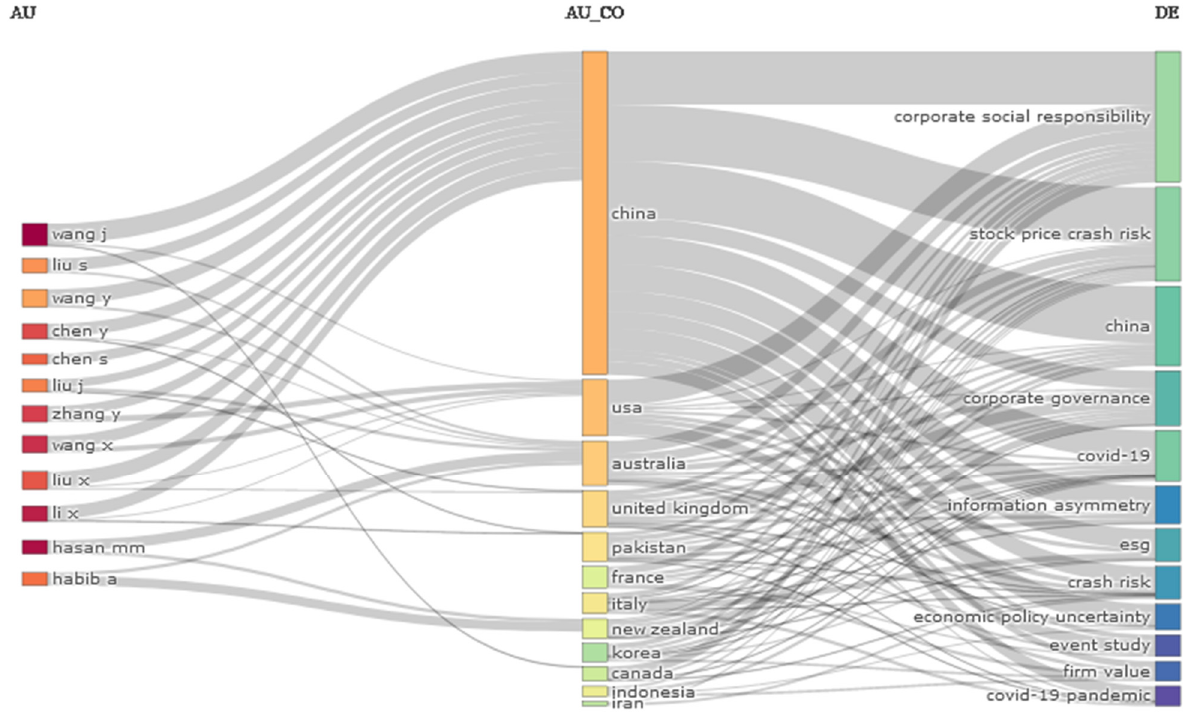
Figure 4. Three-fields plot (Sankey diagram). Source: Scopus/Biblioshiny. Figure 4. Three‑fields plot (Sankey diagram). Source: Scopus/Biblioshiny.